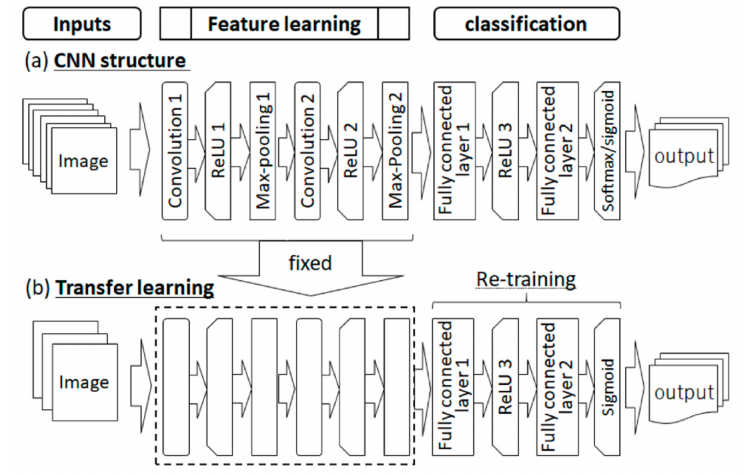
Figure 5. Data flows in procedures ( a ) CNN and ( b ) CNN with transfer